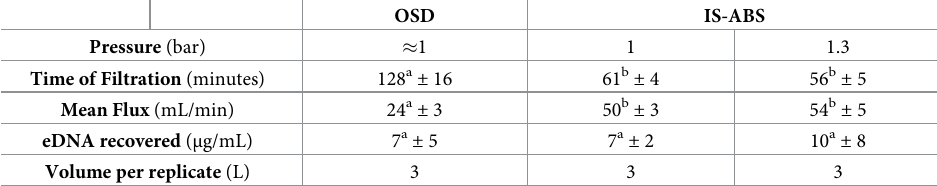
Table 1. Filtration time, volume, average flow and environmental DNA recovered. In the tests performed with the Ocean Sampling Day (OSD) standard procedure and the autonomous biosampler (IS-ABS) (mean ± standard devia- tion, n = 3). For IS-ABS, two filtration pressures were selected. Different superscript letters indicate significant (ANOVA, P < 0.05) differences among the three filtration procedures for each parameter. OSD IS-ABS Pressure (bar) � 1 1 1.3 Time of Filtration (minutes) 128 a ± 16 61 b ± 4 56 b ± 5 Mean Flux (mL/min) 24 a ± 3 50 b ± 3 54 b ± 5 eDNA recovered ( μ g/mL) 7 a ± 5 7 a ± 2 10 a ± 8 Volume per replicate (L) 3 3